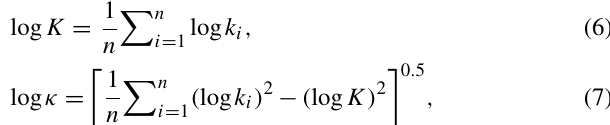
Figure 5. Diagram of the underground soil column structure in the